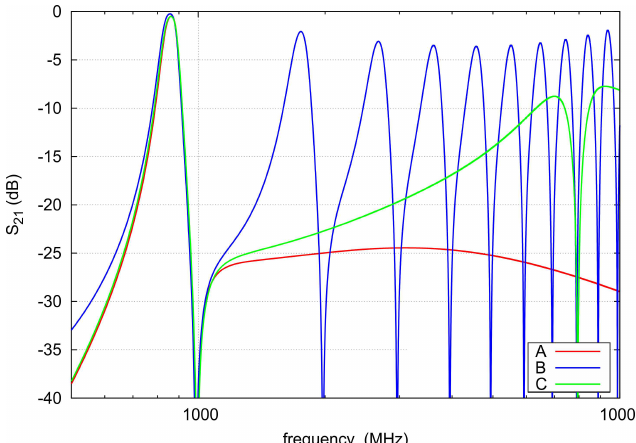
Figure 7. Comparison of the frequency responses of the lumped element prototype filter (A), full transmission line implementation of the prototype filter (B), and capacitively loaded implementation of the prototype filter